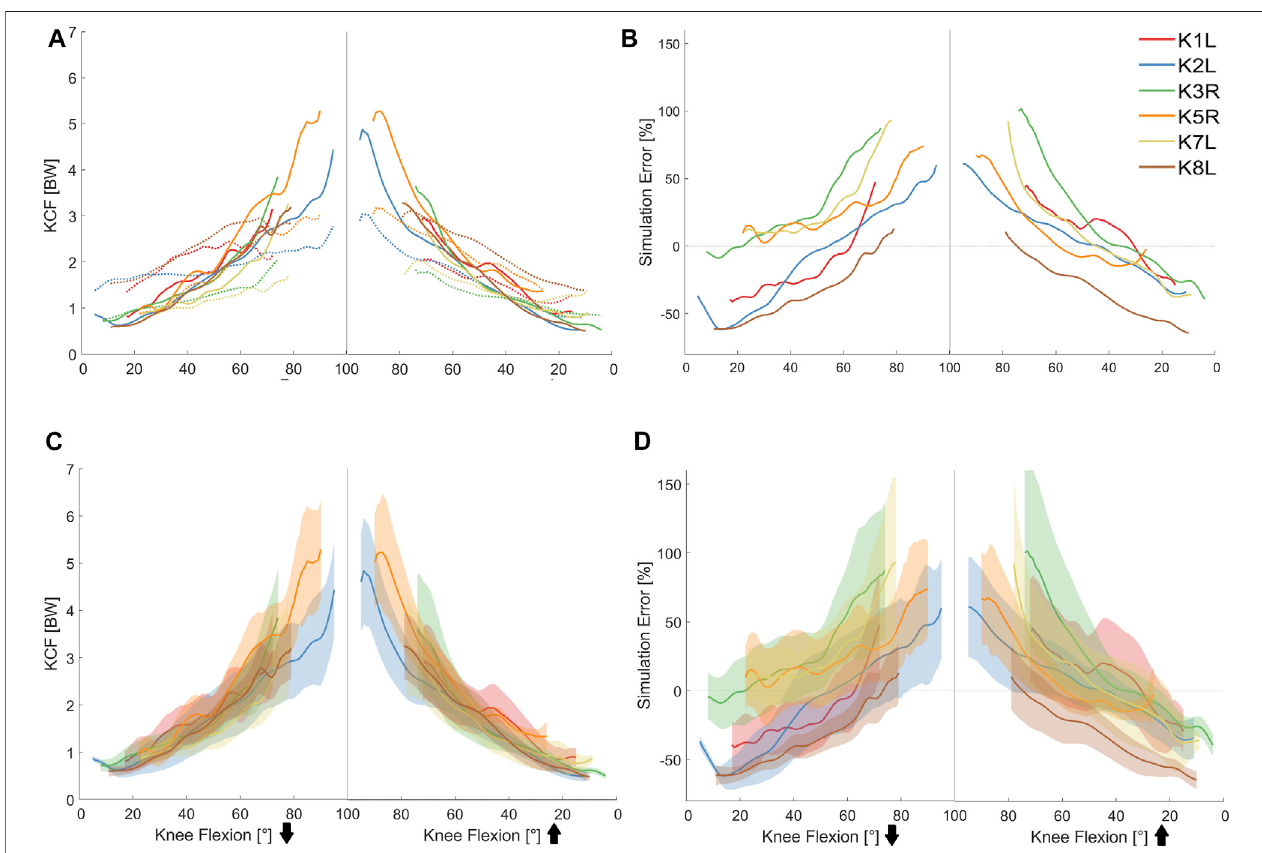
FIGURE 5 | (A) In vivo measured (dotted lines) vs. predicted knee contact forces (solid lines) for the studied squat trials. (B) Simulation errors of the baseline musculoskeletal models. (C) Mean (solid lines) and 5th – 95th percentile range (shaded area) of the knee contact force obtained from general Monte Carlo simulation outputs. (D) Mean (solid lines) and 5th – 95th percentile range (shaded area) of the modeling error calculated from general Monte Carlo simulations.